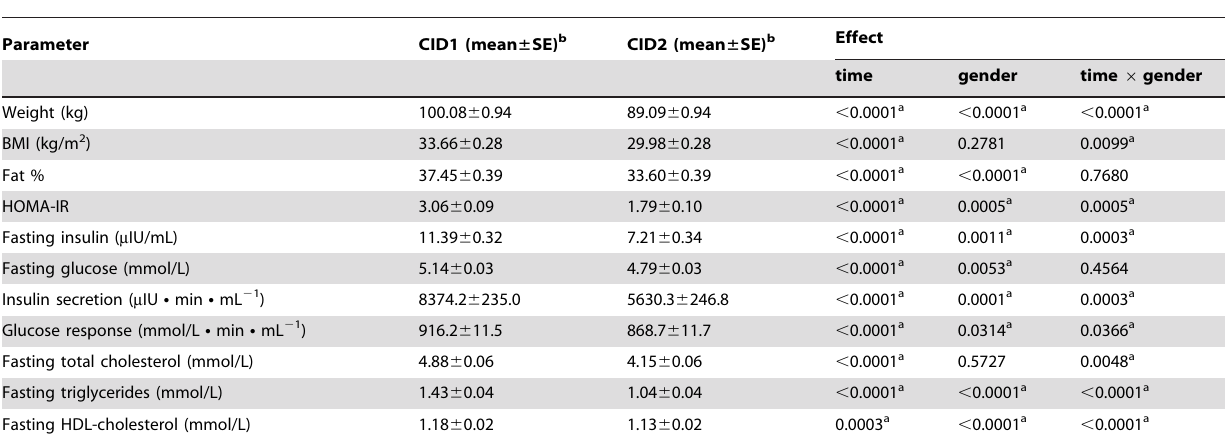
Table 1. Changes in anthropometric & clinical parameters during